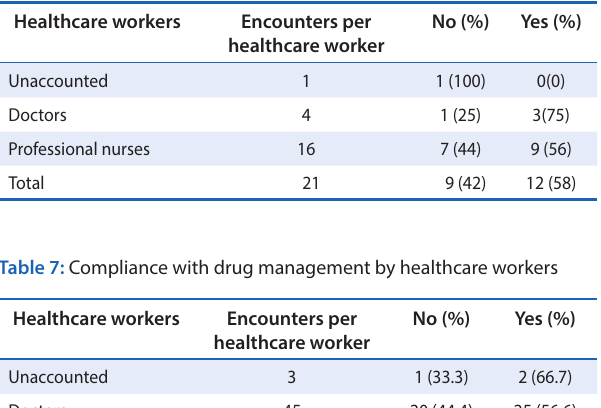
Table 6: Compliance in terms of diagnosis by healthcare workers Healthcare workers Encounters per healthcare worker